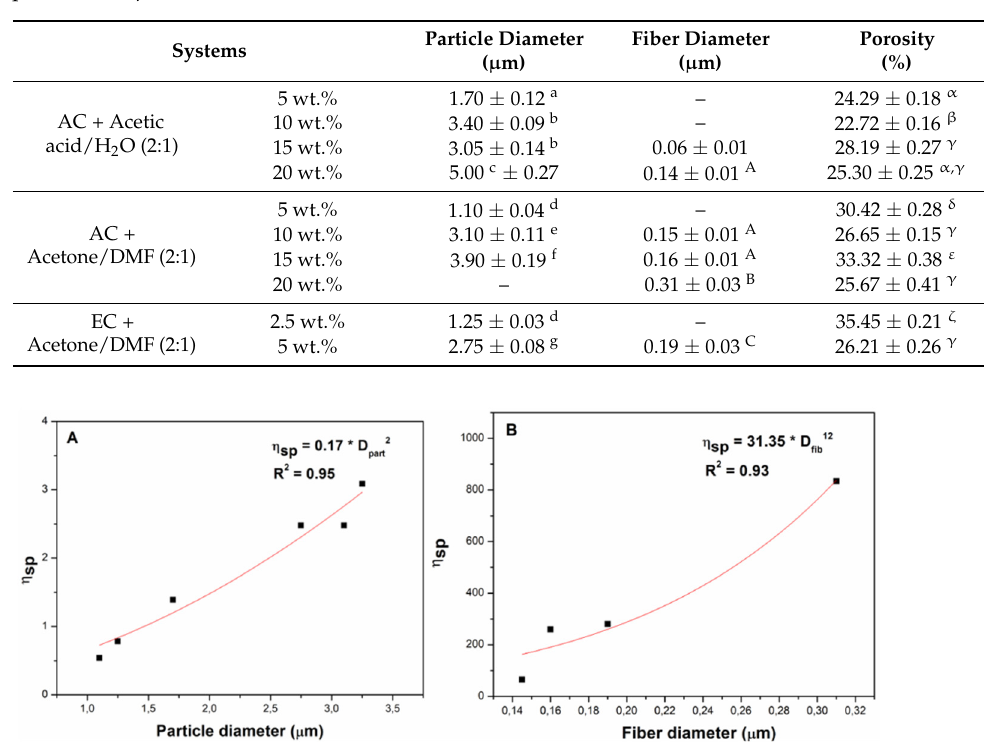
Table 3. Mean values of particles diameter, fiber diameter, and porosity obtained for the different AC and EC systems. Different letters in each column represent significant differences between the parameters ( p < 0.05).